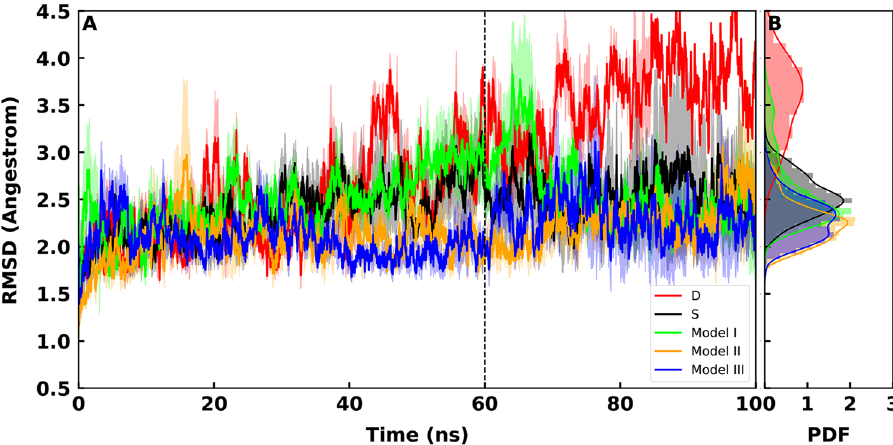
Figure 3. ( A ) Average backbone RMSD plots for RBD-ACE2, calculated from all replicates of each system and are shown for model S (black), model I (lime), model II (orange) and model III (blue). Light shades around each plot presents standard error for each calculation. RMSD of model D is shown in red. ( B ) Probability Density Function (PDF) of RMSD sampled over the last 40 ns (dashed line) of the simulations are shown in histograms.